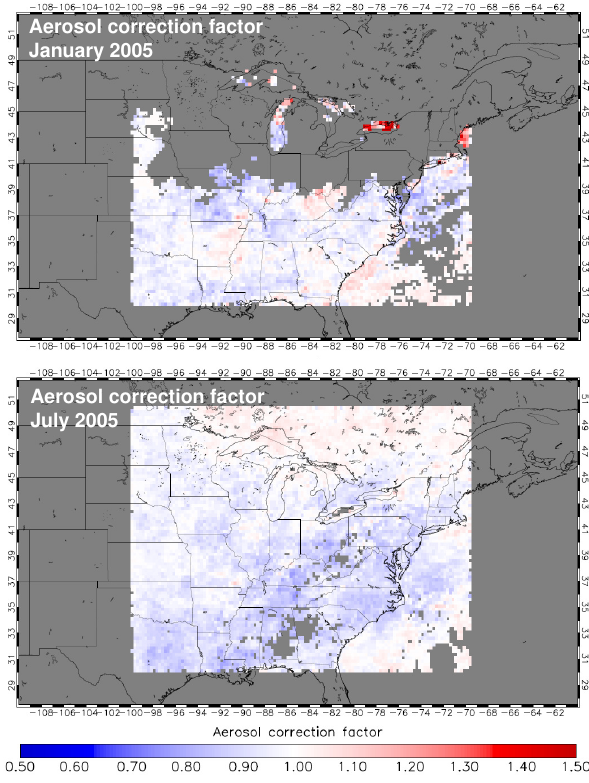
Fig.14. MonthlyaverageaerosolcorrectionfactorforJanuary2005(upperpanel)andJuly2005(lowerpanel). The aerosol correction factor was calculated as the ratio of the tropospheric AMF as used in the DOMINO v1.02 retrieval to the clear-sky AMF (i.e. M / M cr , see Eq. 2). The aerosol correction factor was calculated only for those days and locations that had a successful, cloud-free, MODIS AOT retrieval 15 minutes prior to OMI.Greyareasindicatelessthan3successfulcoincidences.